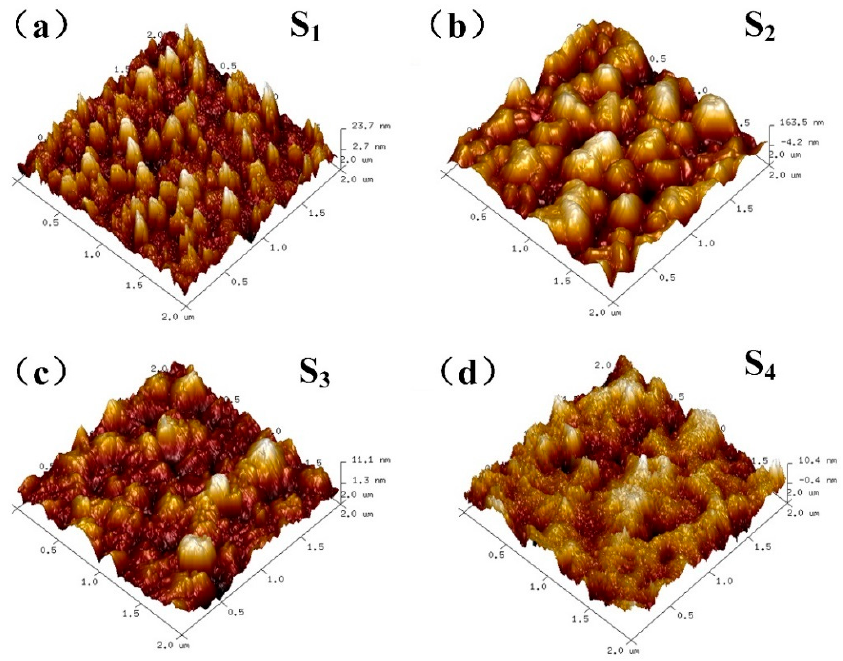
Figure 2. AFM observation of diamond at different growth time after nucleation. ( a ) 5 min; ( b ) 10 min; ( c ) 20 min; ( d ) 40 min.